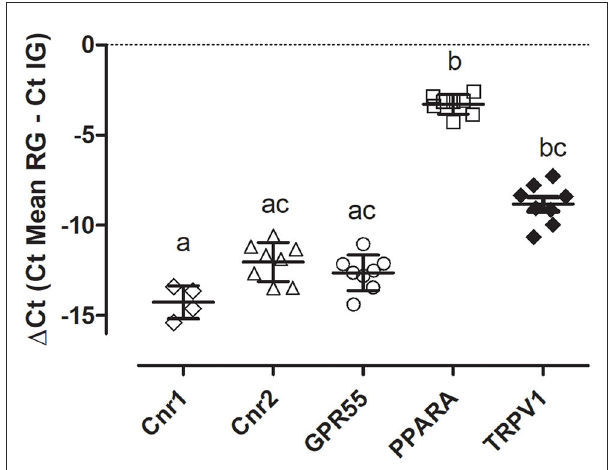
FIGURE1 Gene expression of Cnr1 , Cnr2 , GPR55 , PPARA , and TRPV1 in equine sinovial membranes. The results are presented as 1 Ct = (Ct Mean RG – Ct IG). Symbols indicate individual animals. For each gene, mean ± SD are indicated by horizontal bars. Different letters indicate statistically significant differences ( p < 0.05, Kruskal–Wallis test, Dunn’s Multiple Comparison post-hoc